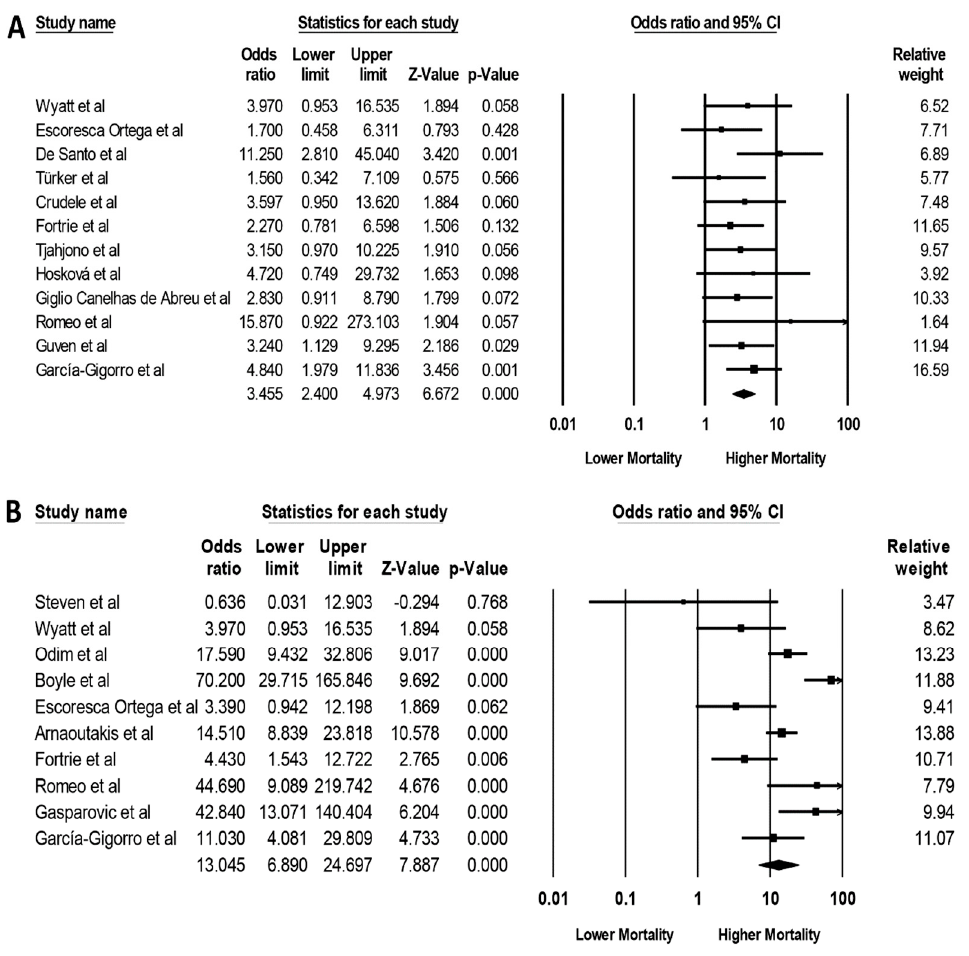
Figure 4. Forest plots of the included studies assessing ( A ) hospital mortality and / or 90-day mortality among patients undergoing cardiac transplantation with AKI and ( B ) hospital mortality and / or 90-day mortality among patients undergoing cardiac transplantation with AKI on RRT. A diamond data label serves as the overall rate from each included study (square data marker) and 95% CI.